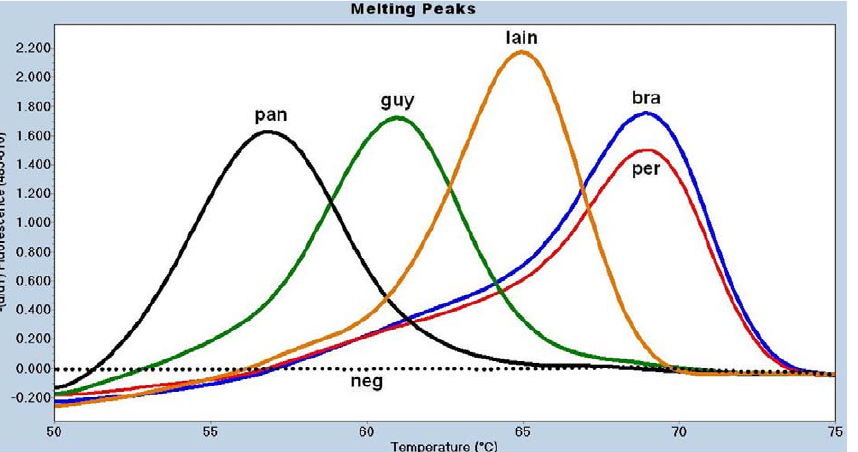
Figure 2. Melting curve analysis for the 6PGD -based real-time PCR assay on Leishmania reference strains. Five nanograms of DNA (references) or 5 ul of nested-PCR products (samples) were used as template to run the assay. The species designation is given based on the Tm calculated for each melting peak (point in the x axis for the peak of the curve). FRET probes on L. ( V. ) panamensis ( pan ) DNA are melted at the lowest temperature (56 u C) while on L. ( V. ) braziliensis ( bra ) or L. ( V. ) peruviana ( per ) DNA are melted at the highest temperature (68 u C). Due to their overlapping Tm , this assay could not differentiate these two species. L. ( L. ) amazonensis , L. ( L. ) mexicana and L. infantum did not yield a melting curve. A straight dotted line corresponds to the negative controls ( neg ), DNA free or parasite-free human DNA. guy = L. ( V. ) guyanensis ; lain = L. ( V. ) lainsoni